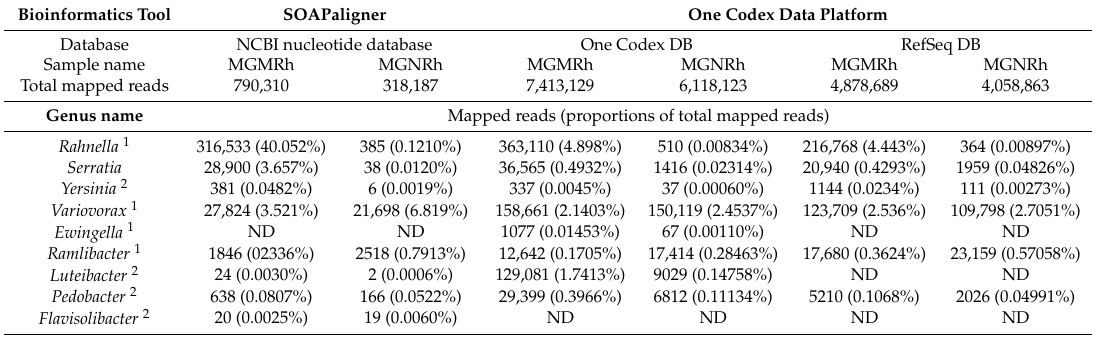
Identification and comparison of special genera in the rhizospheric soil of the glyphosate-tolerant (GT) soy bean line N698 and its control MD12 by shotgun metagenomic